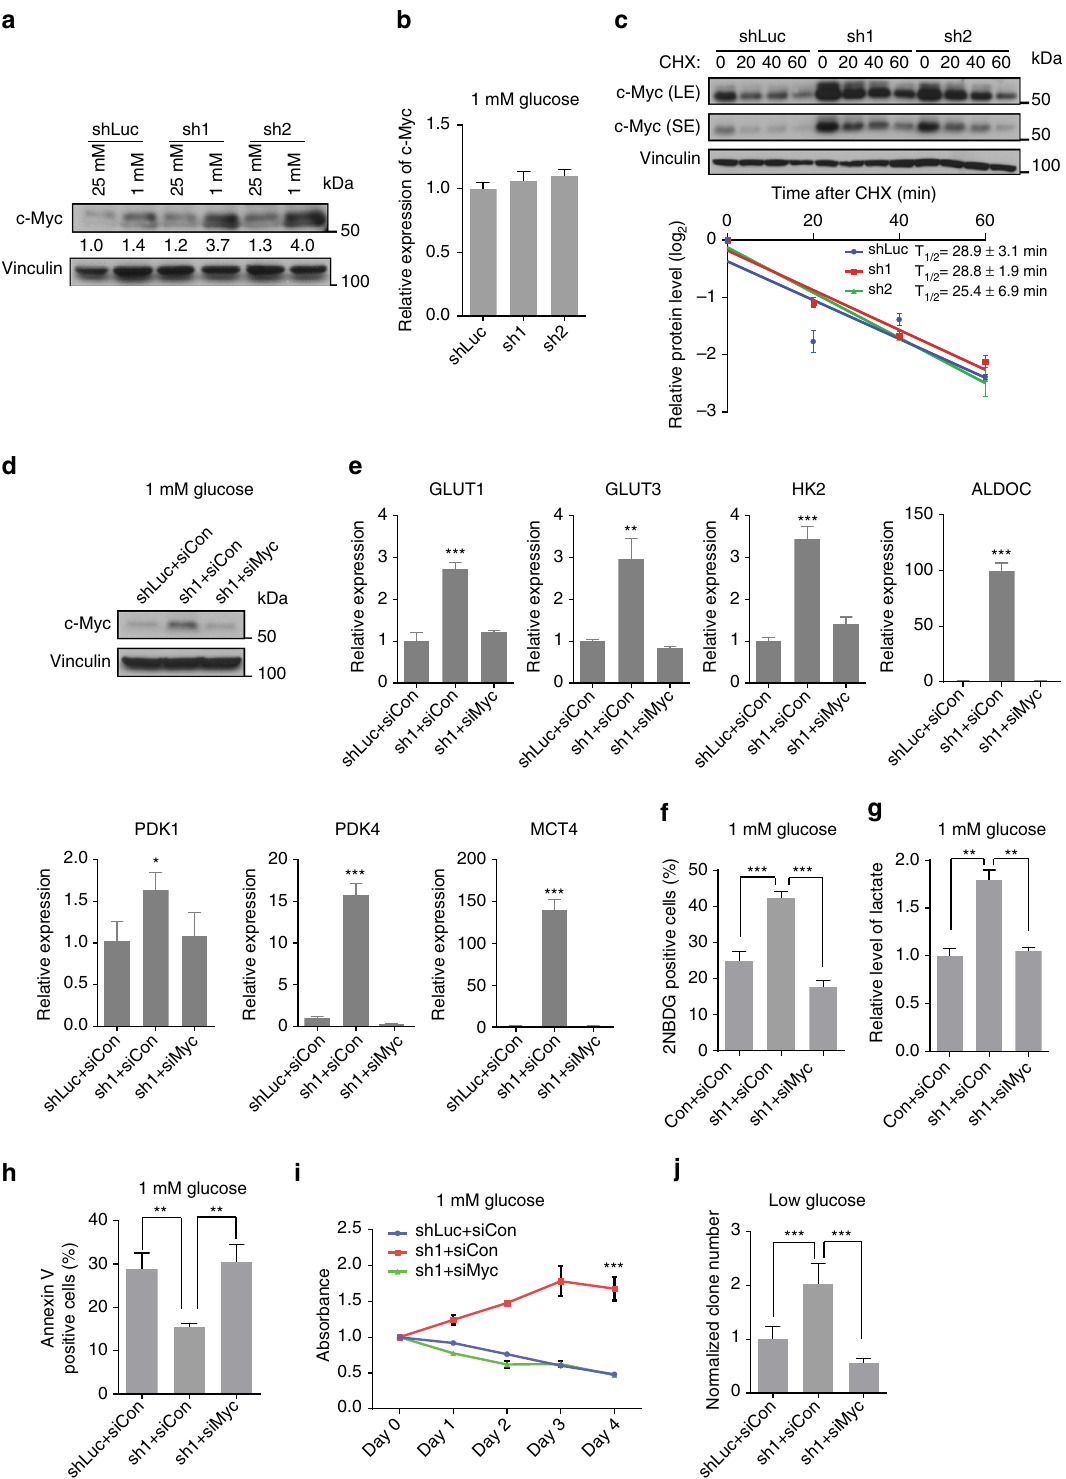
Fig. 4 FILNC1 de fi ciency increases c-Myc protein level. a Control shRNA or FILNC1 shRNA-infected 786-O cells were cultured in 25 mM or 1 mM glucose- containing medium for 24 h, then subjected to western blotting analysis to measure c-Myc protein. b , c Control shRNA or FILNC1 shRNA-infected 786-O cells were cultured in 1 mM glucose-containing medium for 24 h, then subjected to measure c-Myc mRNA using real-time PCR ( b ), or were added with 20 μ g/ml Cycloheximide (CHX) for the indicated periods of time, then subjected to western blotting analysis ( c ). d Control shRNA or FILNC1 shRNA- infected 786-O cells were transfected with c-Myc siRNA. The cells were cultured in 1 mM glucose-containing medium for 24 h, and c-Myc protein level was detected by western blotting. e – j knocking down c-Myc in FILNC1 -de fi cient 786-O cells represses the expression levels of genes involved in glucose metabolism ( e ), glucose uptake ( f ), lactate production ( g ), cell death ( h ), cell growth ( i ), and colony formation in soft agar ( j ) under glucose starvation condition. Values represent mean ± s.d. from three independent experiments, two-tailed Student ’ s t -test. * P < 0.05; ** P < 0.01; *** P <